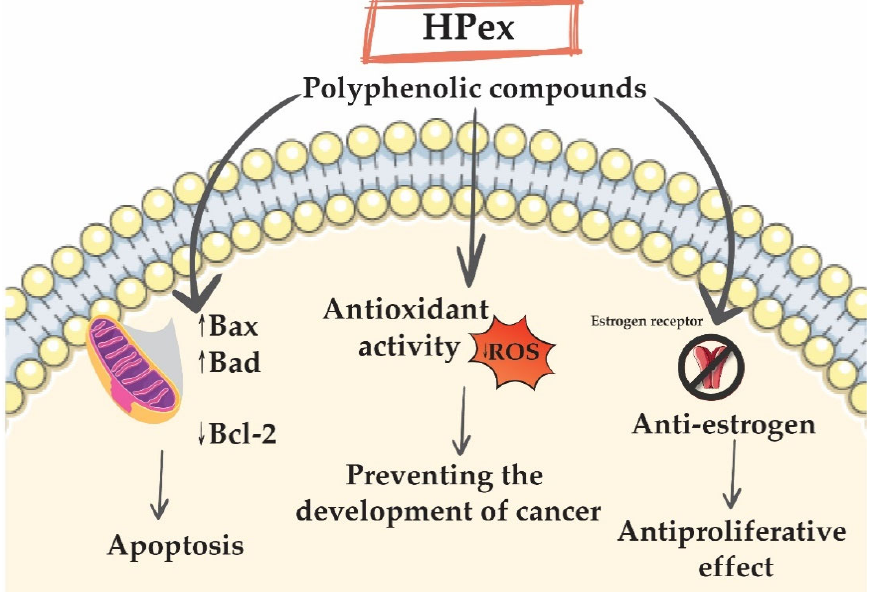
Figure 5. Graphical representation of the possible mechanism of action of Hpex due to its polyphe- nol content.